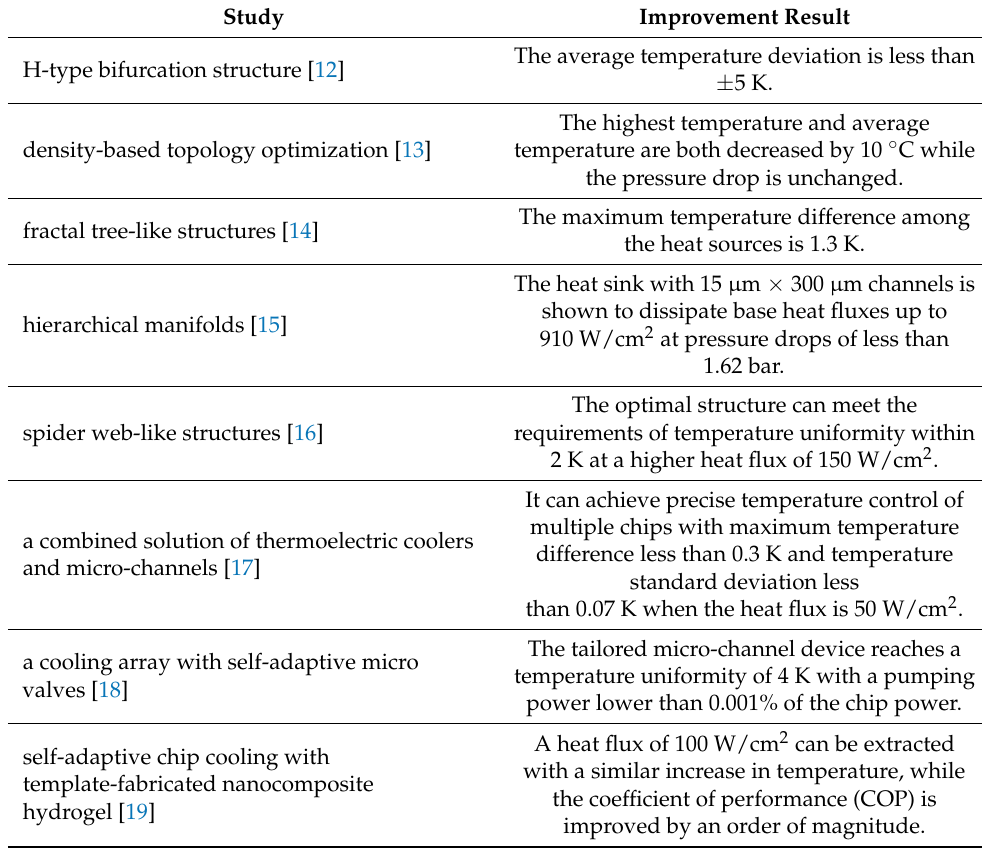
Table 1. Results of previous studies investigating the solution to heat dissipation and temperature uniformity for multiple heat sources. Study Improvement